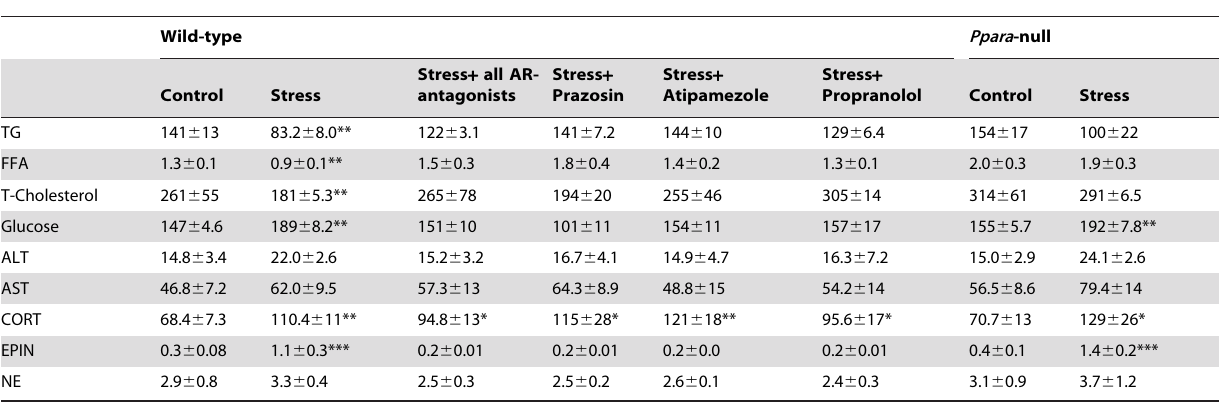
Table 1. Role of PPAR a in the stress-induced changes in serum lipid